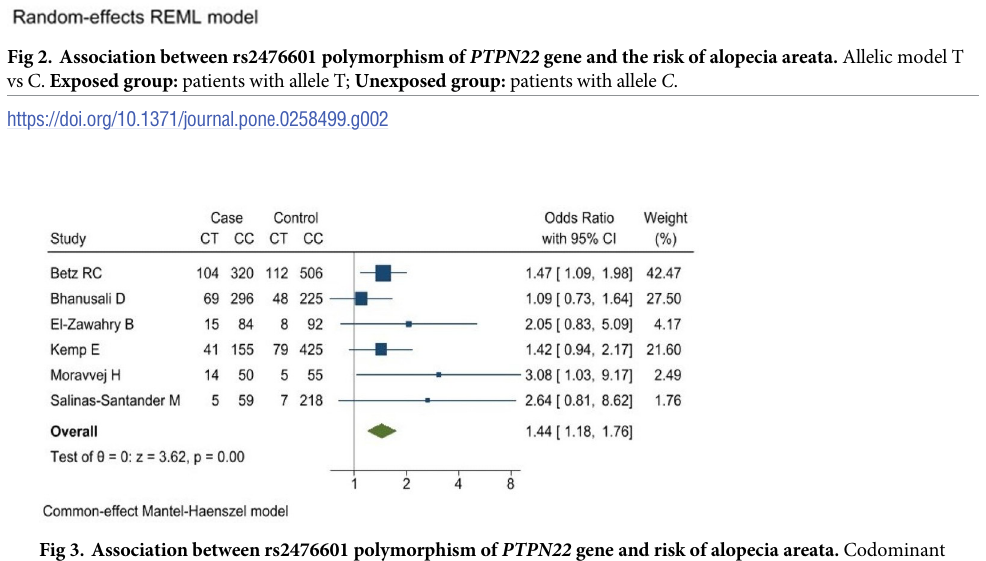
Fig 3. Association between rs2476601 polymorphism of PTPN22 gene and risk of alopecia areata. Codominant model ( CT vs CC ).